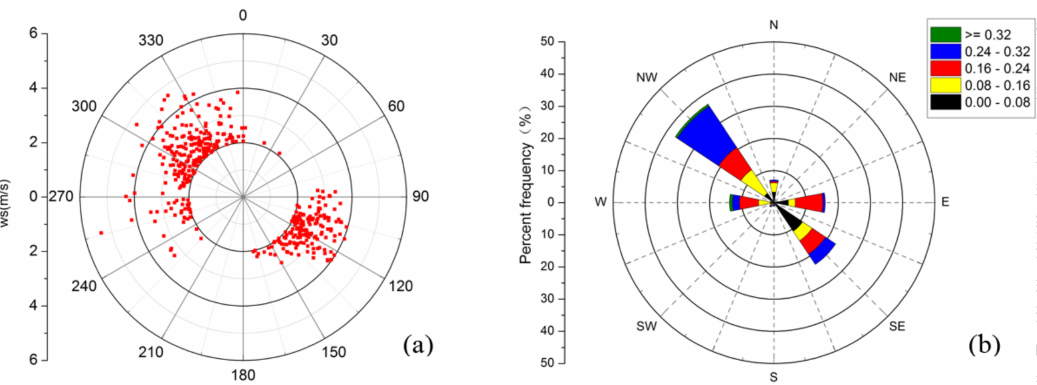
Figure 5. ( a ) Distribution map of half-hourly wind speed data and ( b ) half-hourly z 0m rose-binned data map at Guantan station in August.